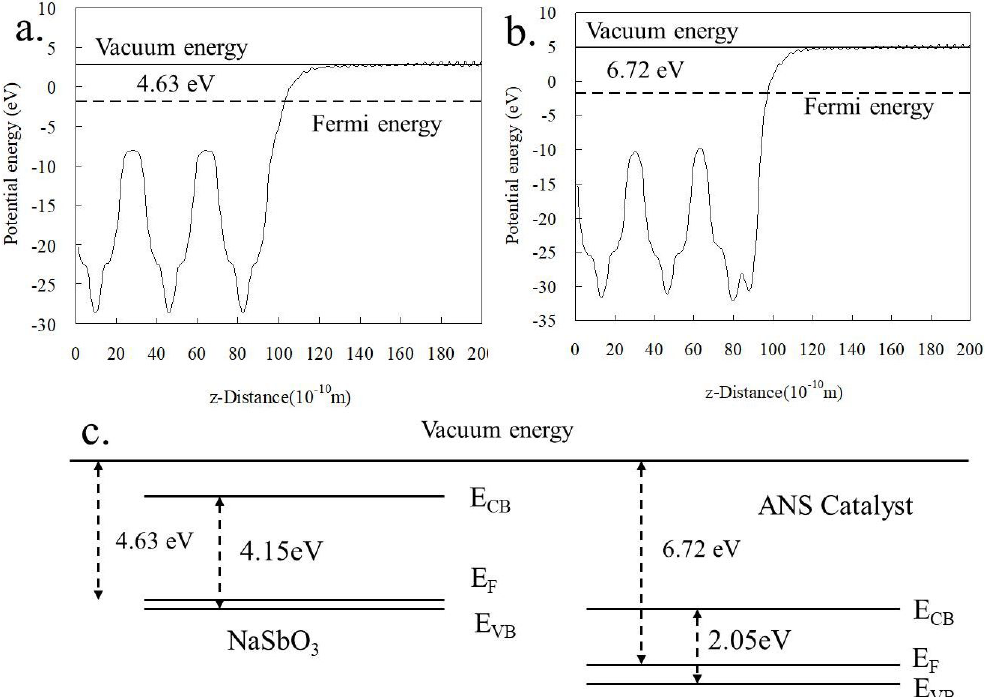
(a) and ANS Catalyst (b), Comparison of energy band structures of NaSbO 3